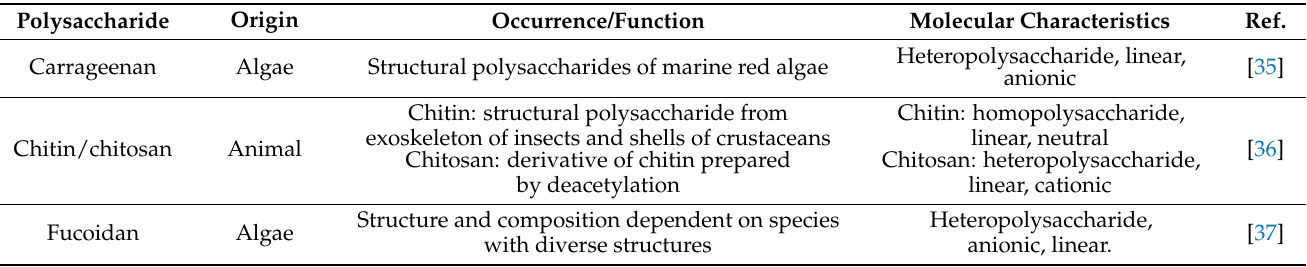
Table 1. Polysaccharides, their origin, and molecular characteristics.